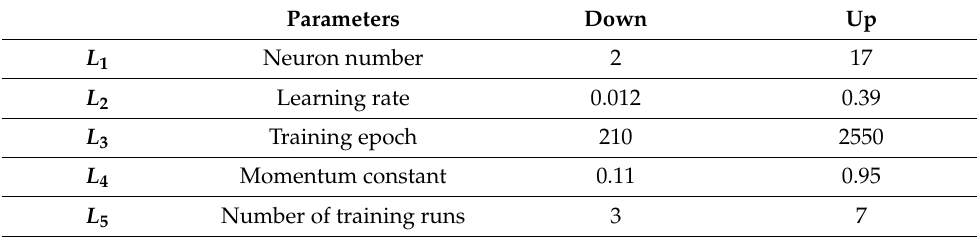
Table 3. The neural network